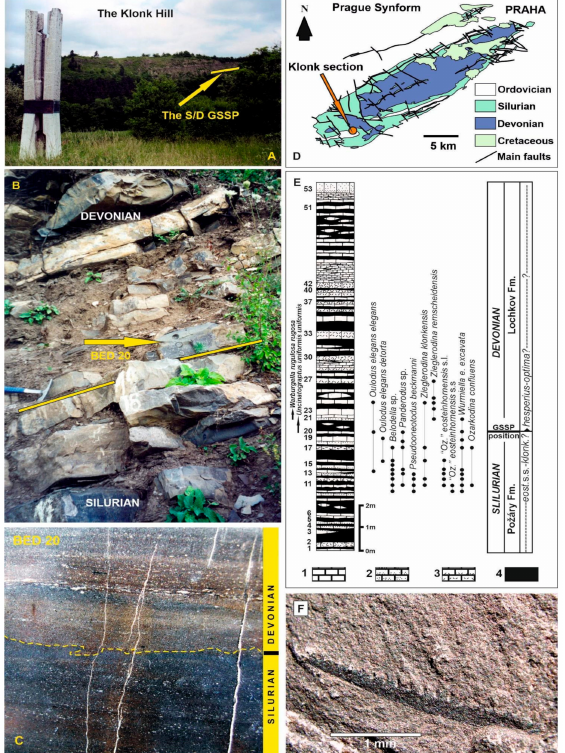
Figure 4. The Global Stratotype Section and Point (GSSP) for the base of the Devonian at Klonk Hill near Suchomasty. ( A )—A view of the Klonk hill near Suchomasty. The yellow line marks the Silurian/Devonian boundary. ( B )—A close-up view of the Silurian/Devonian boundary interval, the base of the Devonian begins in the upper part of Bed 20, as indicated by the yellow arrow. ( C )—Bed 20, a polished section with marking of the boundary (yellow dotted line). ( D )—A location of the GSSP of the Silurian/Devonian boundary at Klonk in simplified geological map of the central part of the Prague Synform. ( E )—Conodont data from the Silurian–Devonian interval showing the position of the first occurrences of stratigraphically relevant taxa in relation to the GSSP. Data from